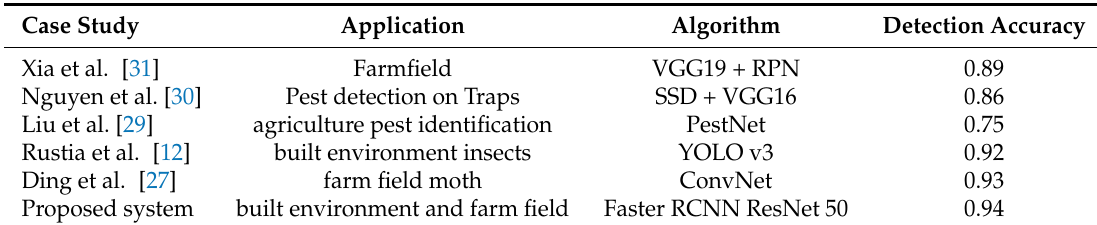
Table 6. Comparison with other insect detection